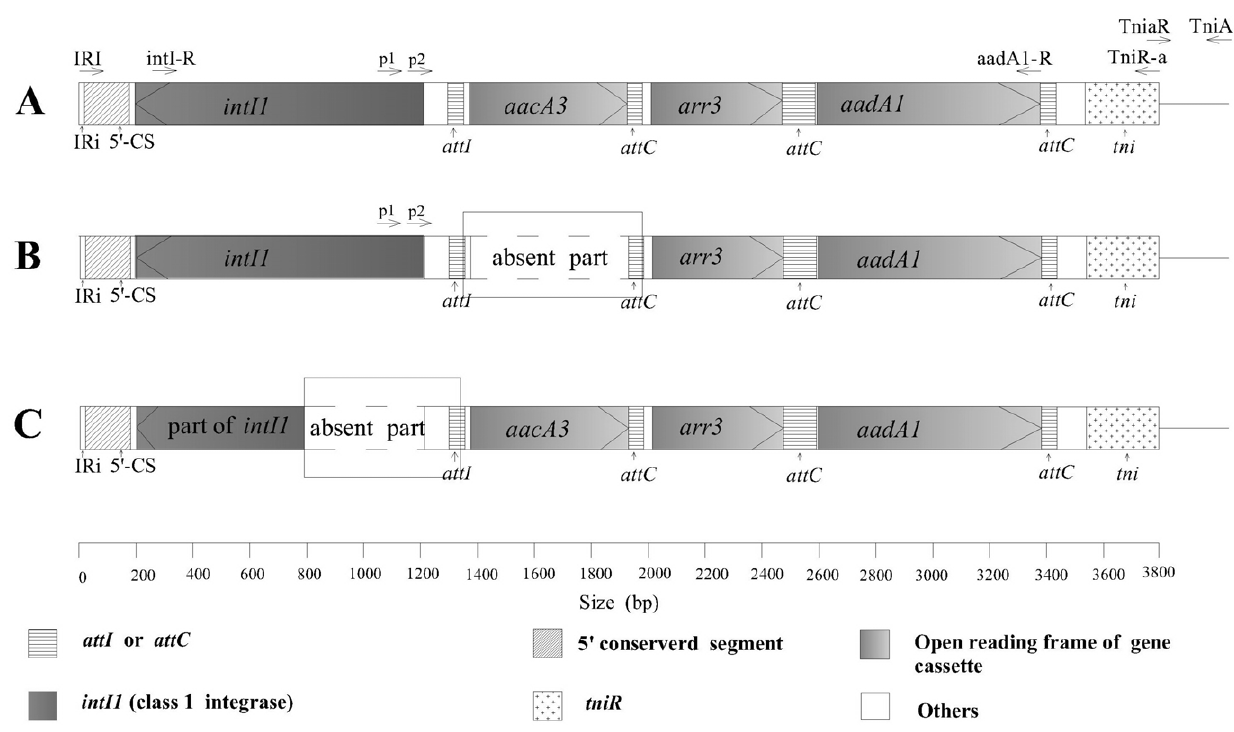
Figure 1. Structural organization of integrons in four resistant isolates of Xanthomonasoryzae pv. oryzae . A. YNA7-1 and YNA11-2; B. YNA10-2; C. YNA12-2. The complete sequences of the resistance integrons in the four resistant isolates through PCR with primer pairs TniR-a and IRI, TniaR and TniA. The resistance integrons in YNA7-1, YNA10-2, YNA11-2, and YNA12-2 contained 7790, 7162, 7790, and 7240 bp, respectively. The sequence of tni module was long and not completely shown in this figure. The sequences of the resistance integrons of YNA7-1 and YNA11-2 were identical. Compared with YNA7-1 and YNA11-2, the sequence from position 1350 to 1977 was absent in the resistance integron of YNA10-2, and the sequence from 791 to 1340 was absent in the resistance integron of YNA12-2. Location of some primers used for PCR is shown in the figure. P1 and p2 are promoter areas of integrons.